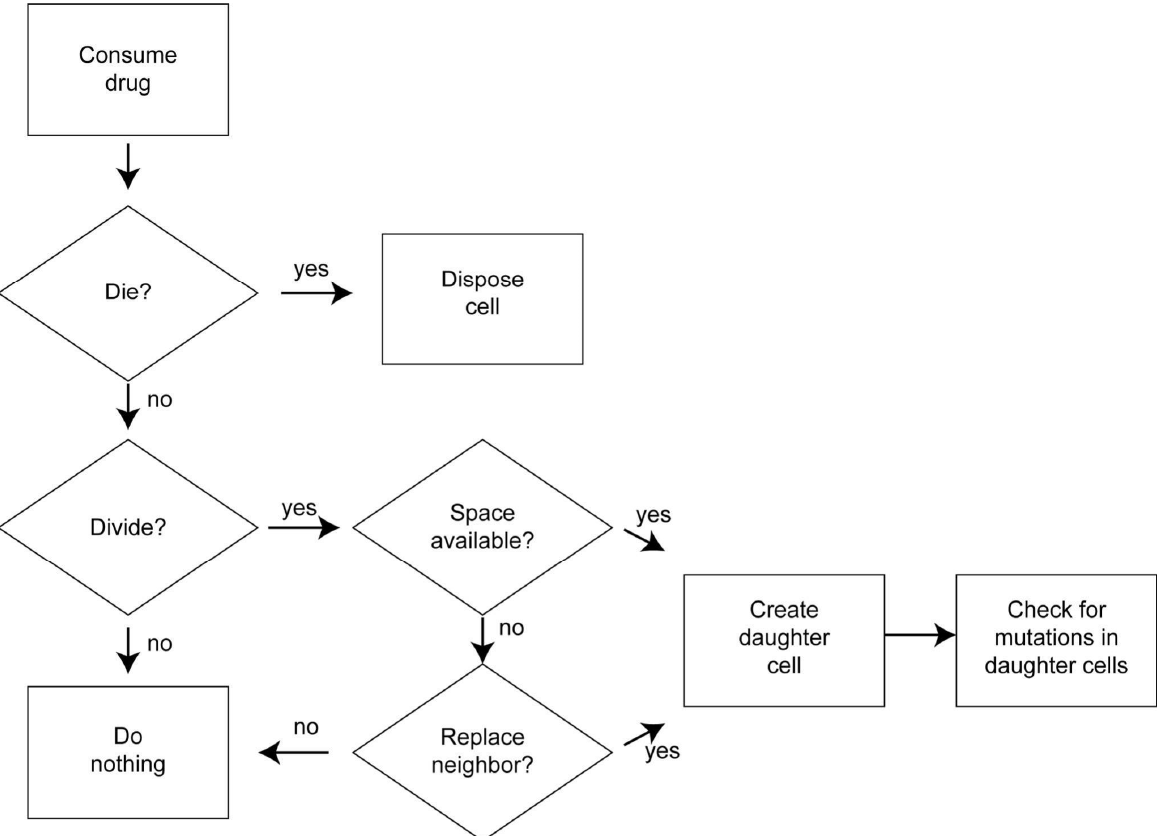
Figure 1. Process overview and scheduling. Cells die as a function of their sensitivity to the drugs, the available drug concentrations and the background death function. A cell divides as a function of its doubling time (resistant cells have slower doubling times). The effects of cell crowding, cell cannibalism and contact inhibition are represented by a probability of replacing a neighbor if there is no open space.